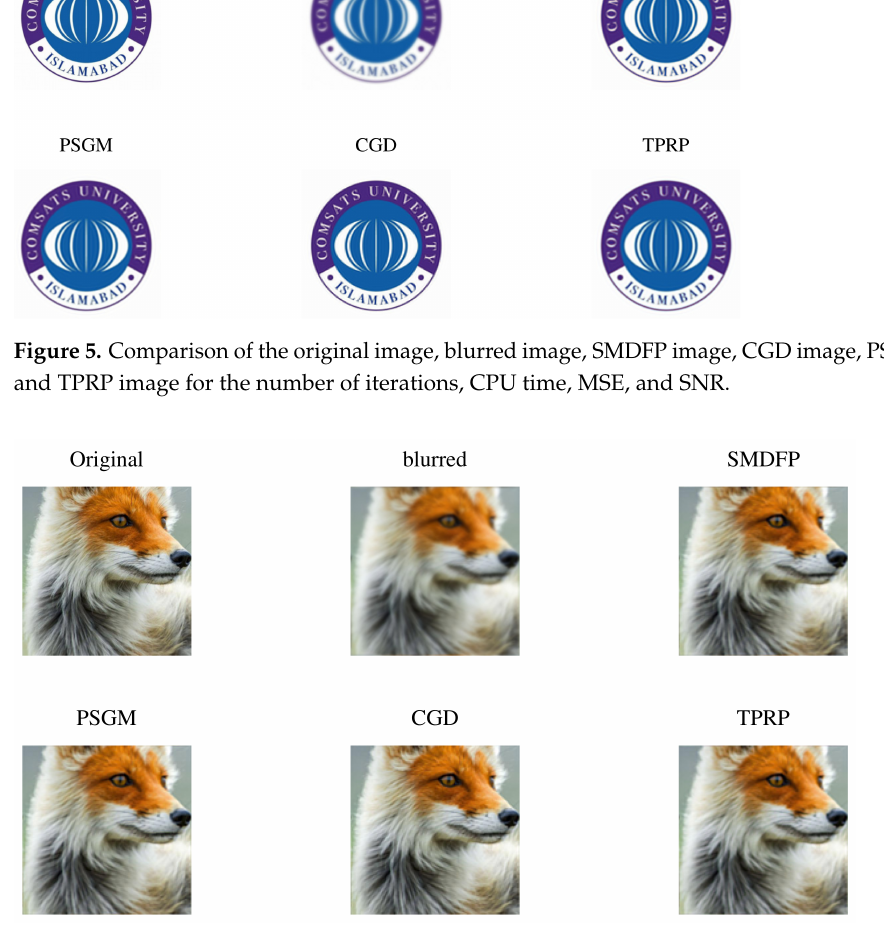
Figure 6. Comparison of the original image, blurred image, SMDFP image, CGD image, PSGM image, and TPRP image for the number of iterations, CPU time, MSE, and SNR.